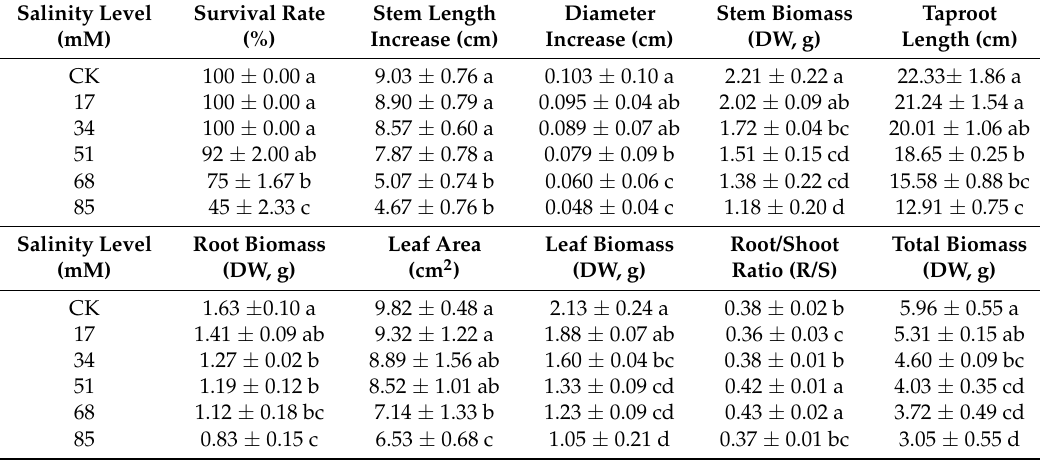
Table 1. Effects of various salinities on the survival rate, stem length increase, diameter increase, stem biomass, taproot length, root biomass, root/shoot ratio, leaf area, leaf biomass and total biomass of Carpinus turczaninowii L. after 42